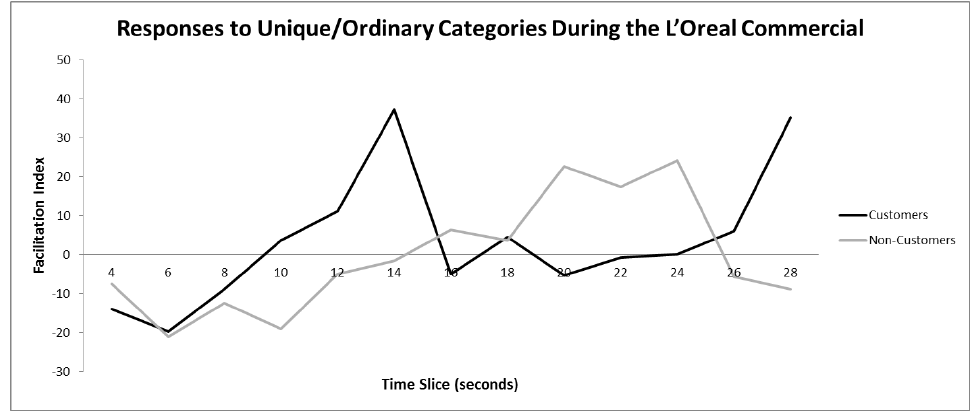
Figure 6. Trace of IMPULSE whilst viewing the L’Oréal commercial for customers of L’Oréal products and noncustomers. Positive scores indicate feelings congruent with Unique and/or Positive, negative scores indicate feelings congruent with Ordinary and/or Negative.